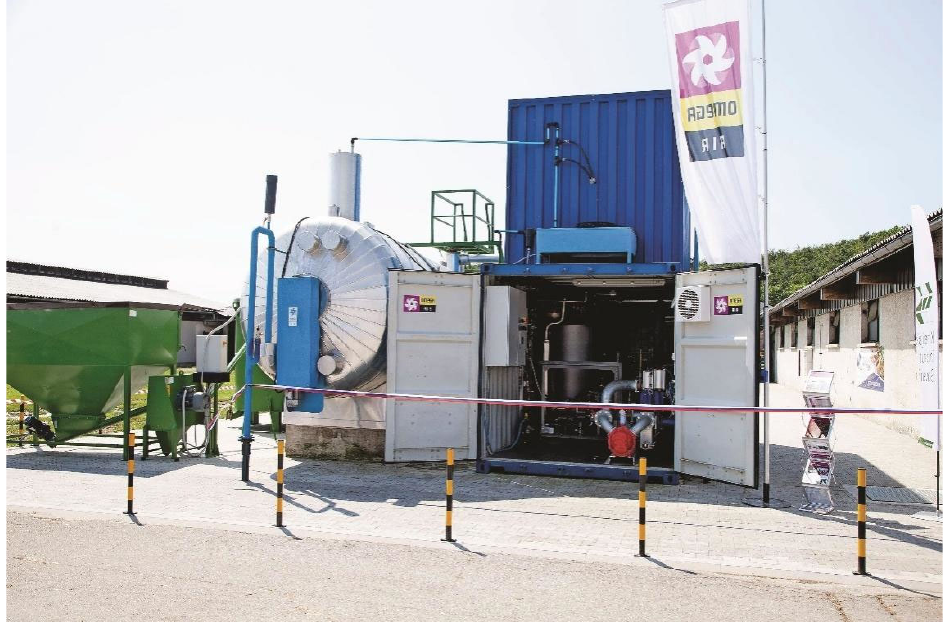
Figure 3. Micro ‐ biogas plant—Agricultural Institute of Slovenia [30]. Figure 3. Micro-biogas plant—Agricultural Institute of Slovenia [30].